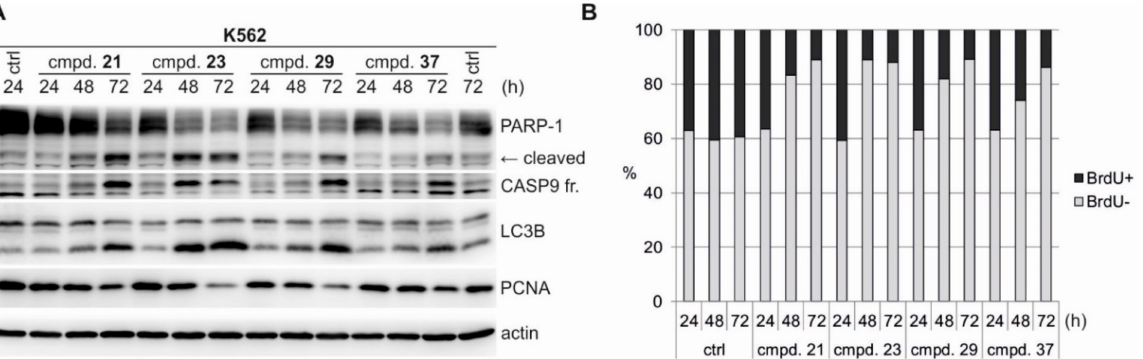
Figure 2. Effect of compounds 21 , 23 , 29, and 37 (10 µ M) on K562 cell line after 24, 48, and 72 h treatment. ( A ) Immunoblotting of selected markers of cell death and proliferation. The actin level was detected to verify equal protein loading. ( B ) Analysis of BrdU incorporation. Results are representative of two independent